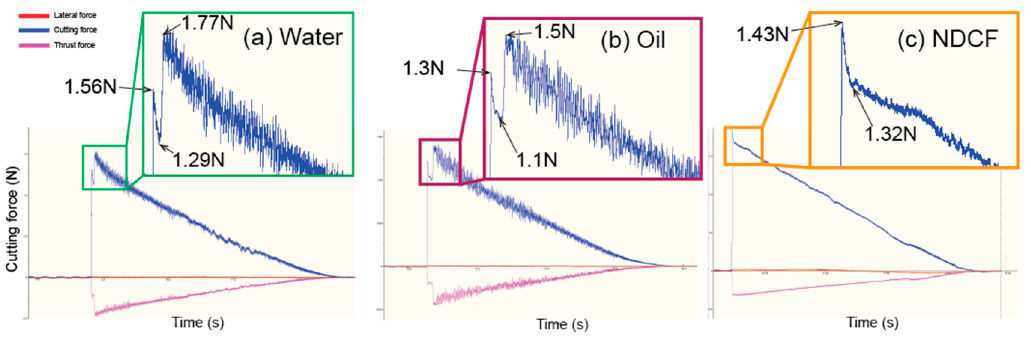
Figure 7. Effect of various cutting fluids on the cutting force in the taper cutting: ( a ) water; ( b ) oil; ( c ) NDCF.